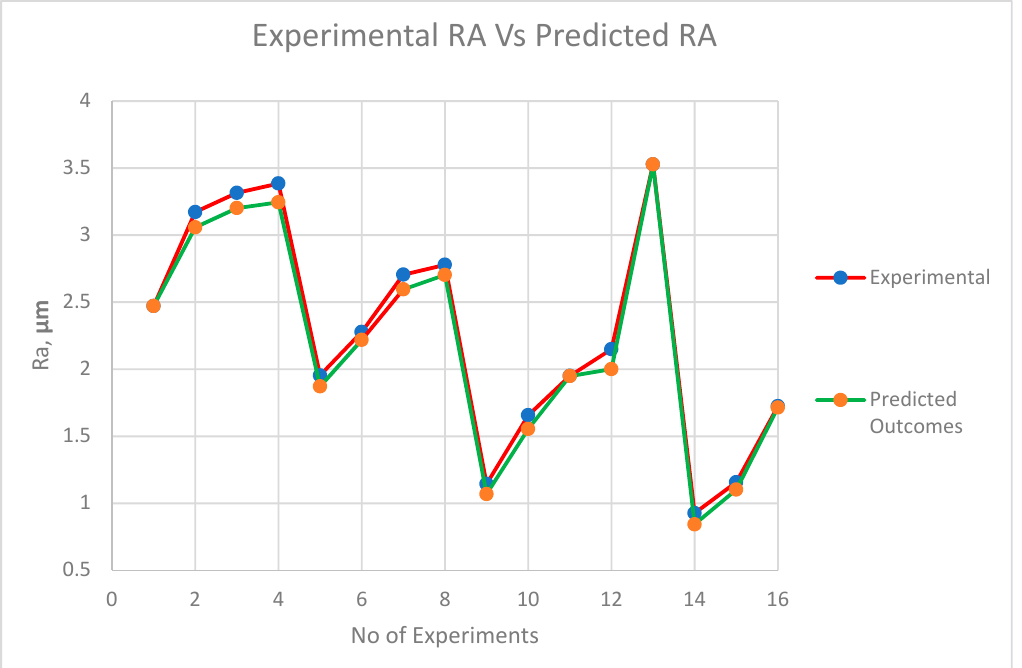
Figure 9. Plot of experimental surface roughness (Ra) vs. predicted surface roughness (Ra).